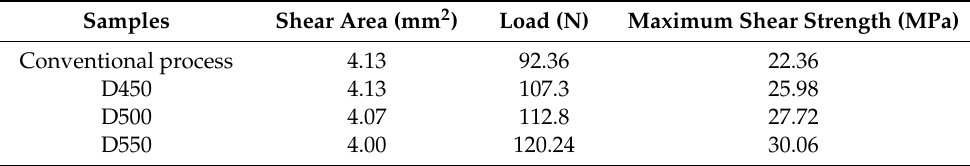
Table 3. Maximum shear strength of hot-rolled Al/Ti LMCs.